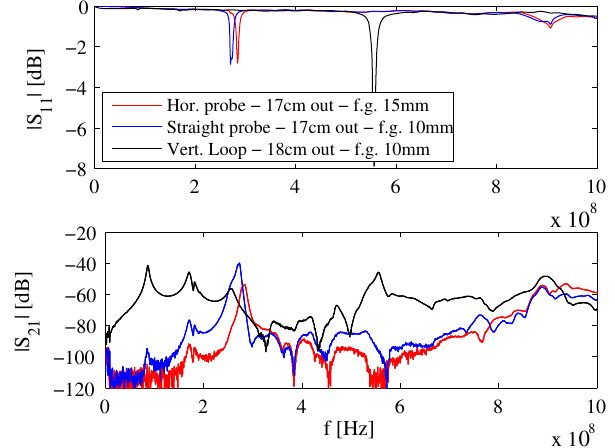
FIG. 9. S11 (top) and S12 (bottom) measured with a straight and horizontal probe and with a loop: the low frequency resonant modes exhibit higher coupling through the magnetic field. The first length in the legend refers to the portion of probe outside the device, the second ( “ f.g. ” ) to the full gap of the